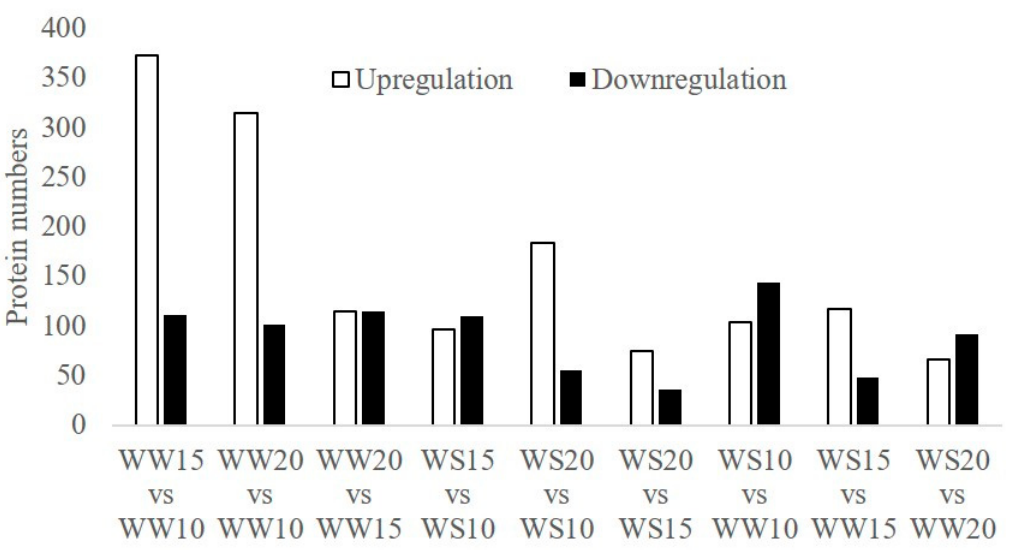
Figure 4. Number of proteins differently expressed in pod walls under drought stress. The white and black squares represent, respectively, significant upregulation and downregulation at the 0.05 probability level.